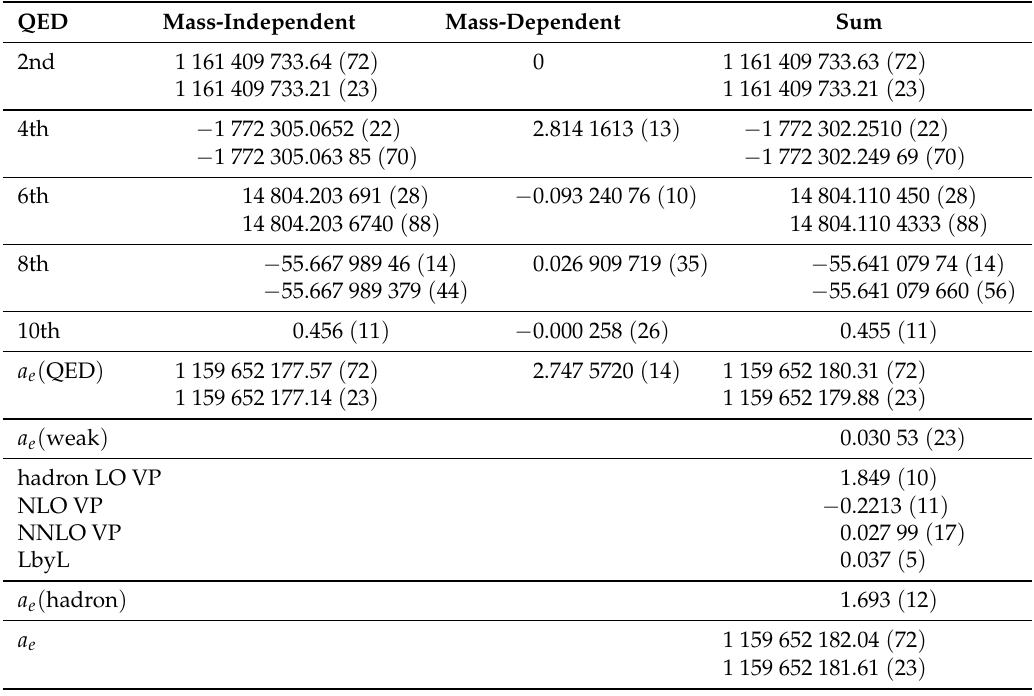
Table 2. Standard model contributions to the electron anomalous magnetic moment a e in units of 10 − 12 . The second-, fourth-, sixth-, and eighth-order mass-independent contributions of QED are evaluated with two values of the fine-structure constant: the upper and lower numbers are determined with α ( Rb ) of the Rb atom recoil and α ( Cs ) of the Cs atom recoil measurements, respectively. The difference of two values of α does not affect other QED contributions, weak or hadronic contributions. The weak and hadronic contributions are quoted from [22]. The hadronic contribution is further divided into the leading-order (LO) vacuum-polarization (VP) contribution, the next-to-leading-order (NLO) VP contiribution, the next-to-next-to-leading-order (NNLO) VP contribution, and the light-by-light scattering (LbyL)